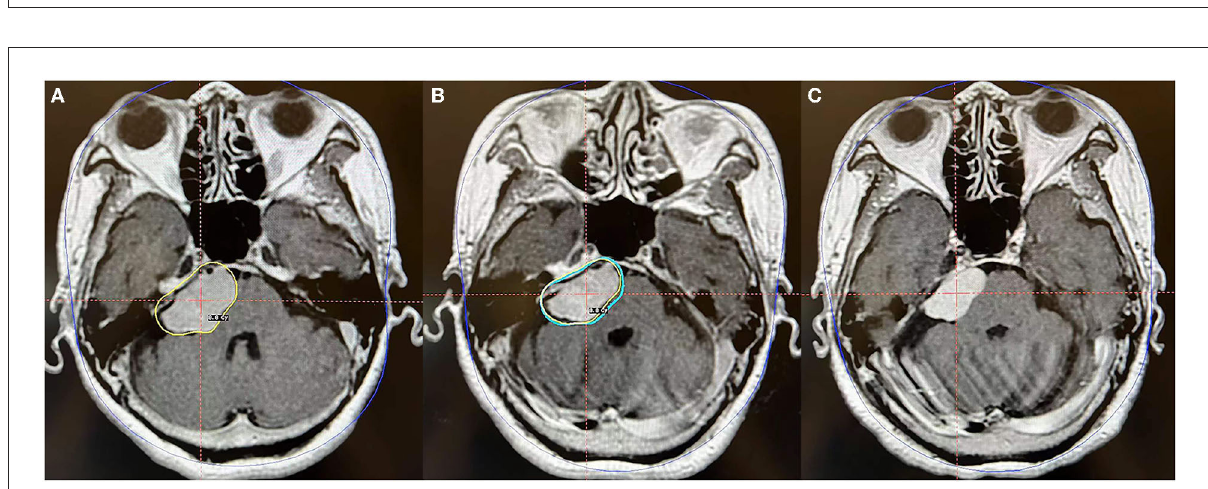
FIGURE5 Axial MR imaging illustrating a posterior petrosal meningioma treated with Gamma Knife radiosurgery. (A) The prescription dose planning MRI for the first stage of Gamma Knife radiosurgery presenting that the tumor margin was covered by 8.8Gy (45% isodose surface), and the tumor volume was 11.0 cc. (B) In the second fraction, the tumor was treated repeatedly with the same precision dose as in the first stage, and the tumor volume was 8.4 cc. (C) MRI obtained 24 months after radiosurgery revealed that the tumor volume is 6.1 cc and is decreased by 44.5% compared with that pre-radiosurgery. No obvious adverse reactions were